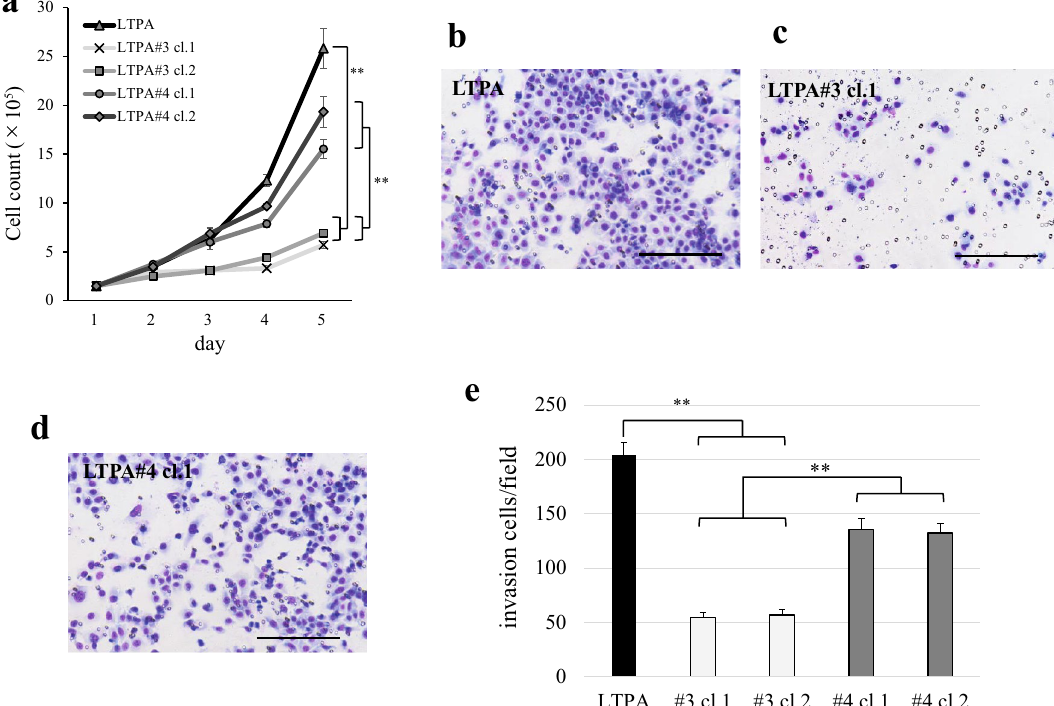
Figure 3. Induction of human chromosome 3 into LTPA cells inhibits cell proliferation and invasion. ( a ) Cell numbers for LTPA, LTPA#3, and LTPA#4 cells over a 5 day period. The bars correspond to means ± S.E. of three independent experiments (** P < 0.001). Representative images of the invasion assay for ( b ) LTPA, ( c ) LTPA#3, and ( d ) LTPA#4 cells. Scale bar 200 µm. ( e ) Counts of invading cells per five microscopic fields for LTPA, LTPA#3, and LTPA#4 cells. The bars correspond to means ± S.E. of three independent experiments (** P <